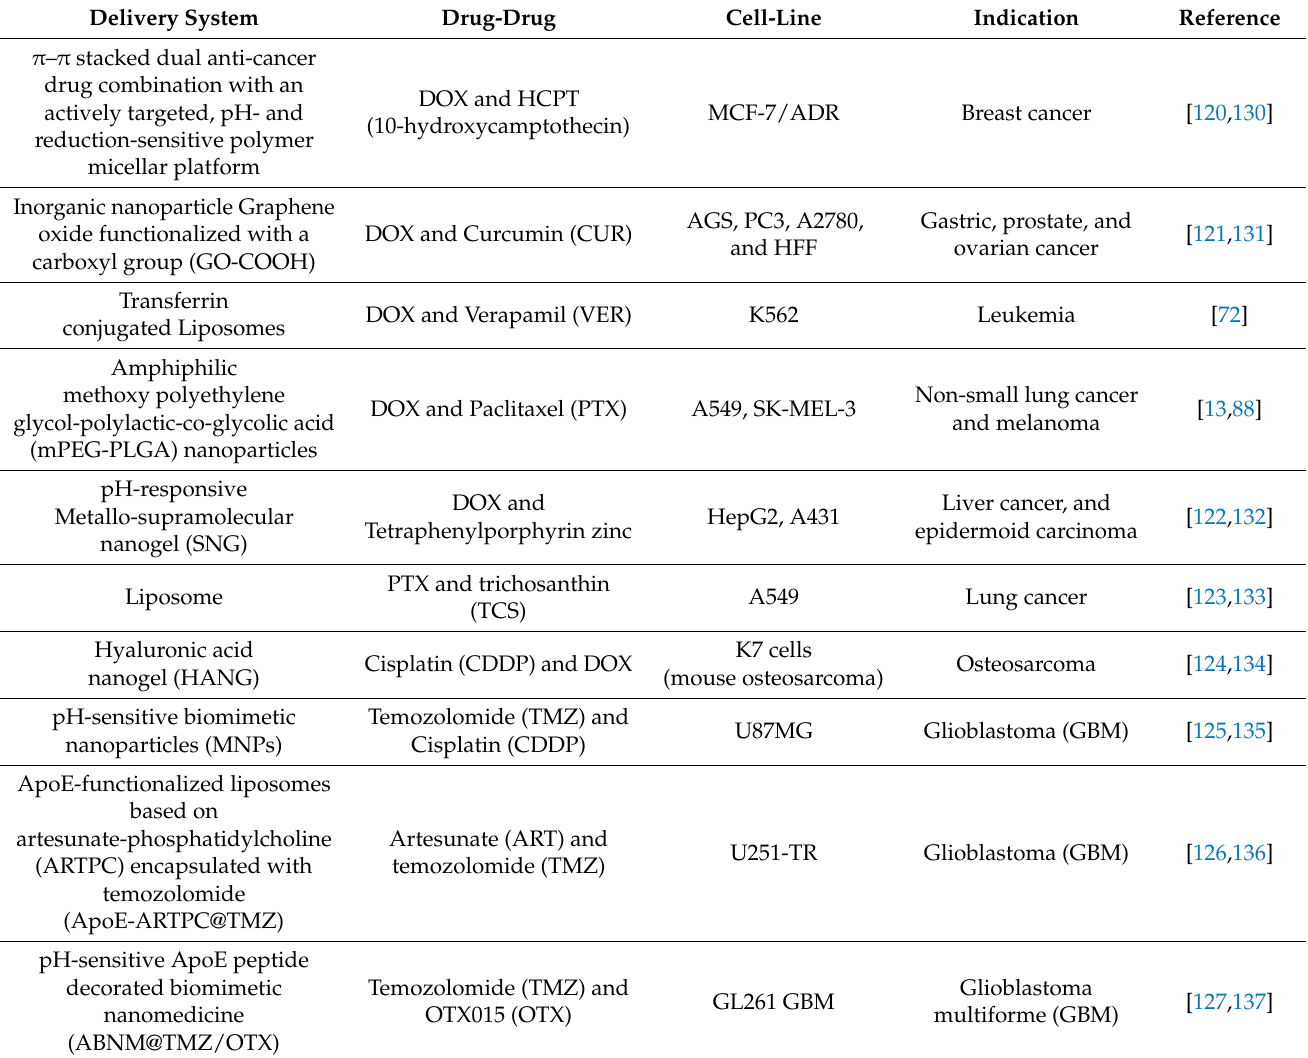
Table 3. Co-delivery of drug-drug by various nanocarrier systems for cancer